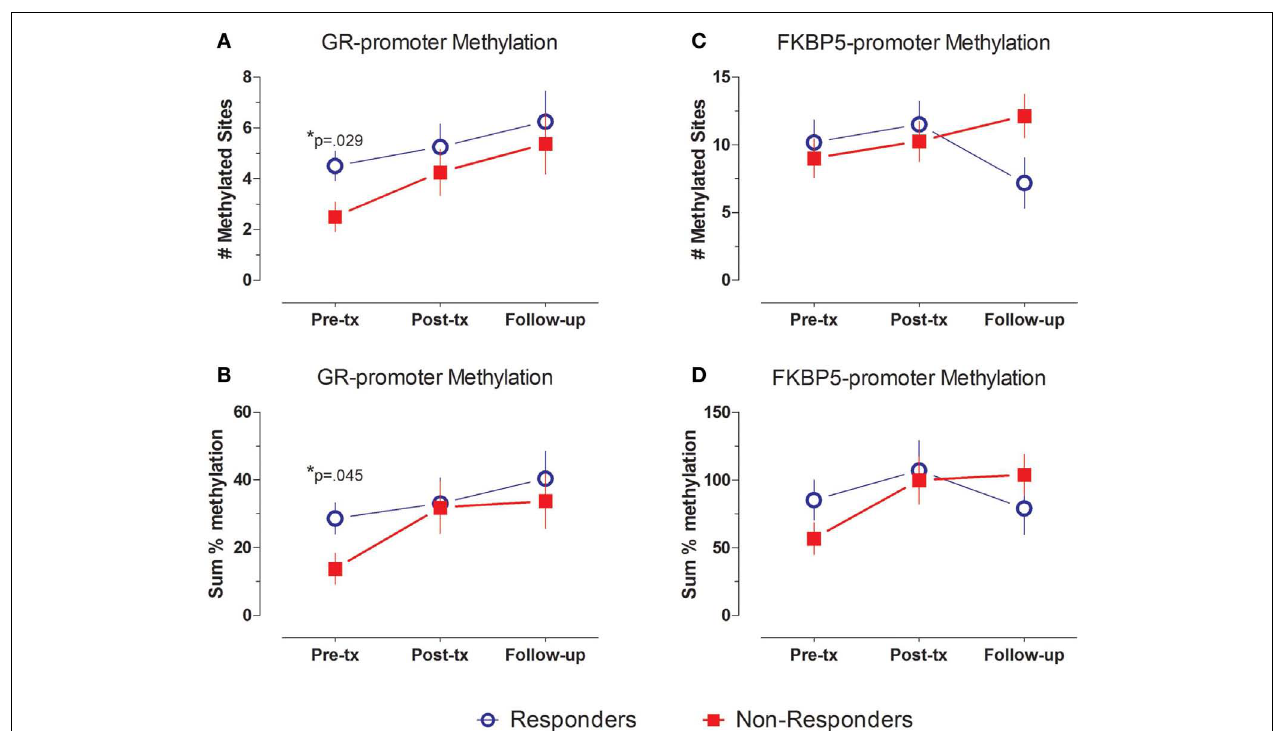
squares. For GR exon 1F promoter methylation, there is a significant group difference at Pre-treatment, but no main effect of time and no group by time interaction. FKBP5 promoter methylation shows a significant group by time interaction, but no main effects of group or time. Statistical significance was set at p < 0.05.